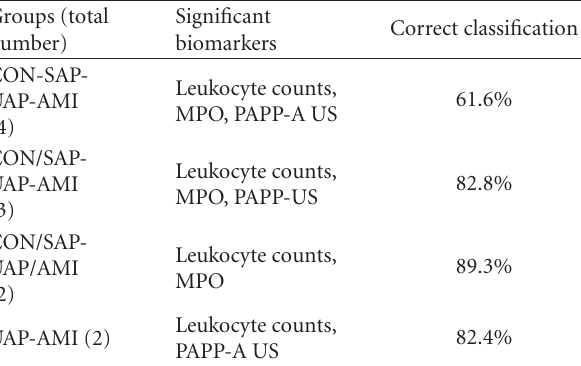
Table 3: Results of di ff erent discriminant